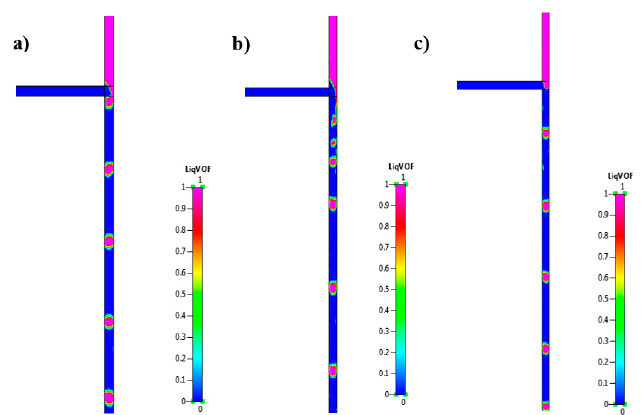
Figure 5. Microbubble formation in the T-junction ( a ) without an electric field; ( b ) DC electric field of 6 kV DC; and ( c ) AC onto DC of 2 kVP–P, 6 kV, 2 kHz.